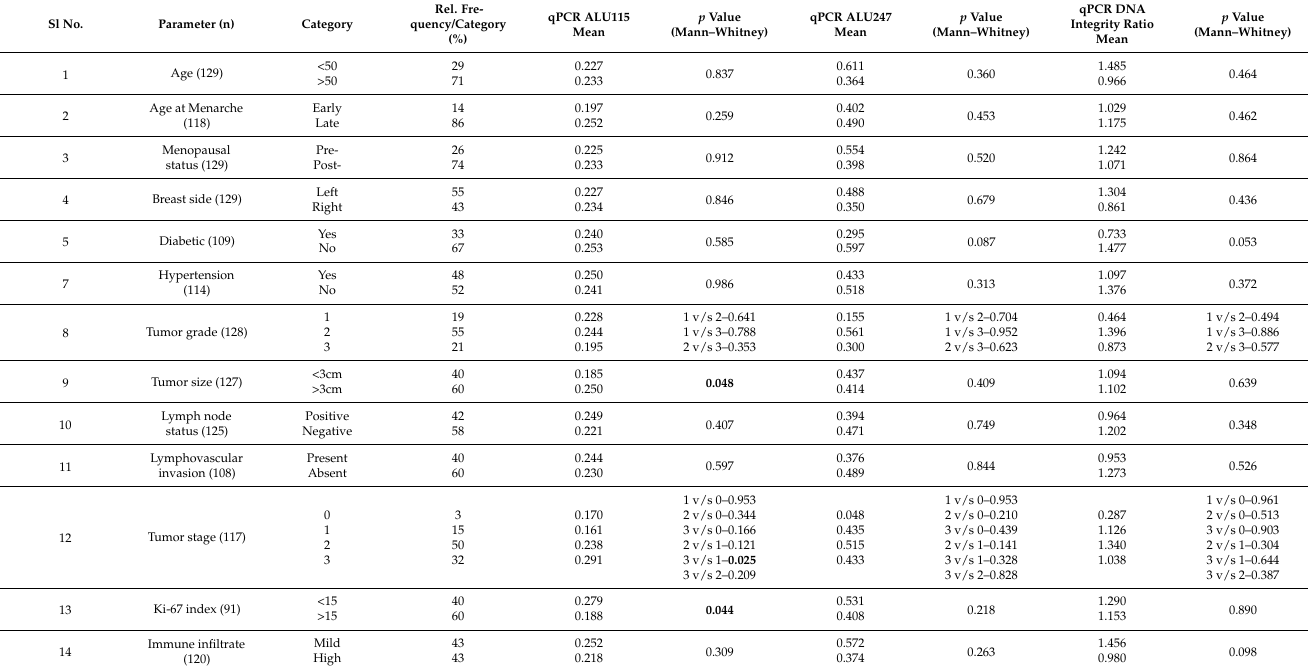
Table 1. Association between ALU 115, ALU 247, and DNA integrity ratio with various clinico- pathological features of primary tumors from n = 132 breast cancer